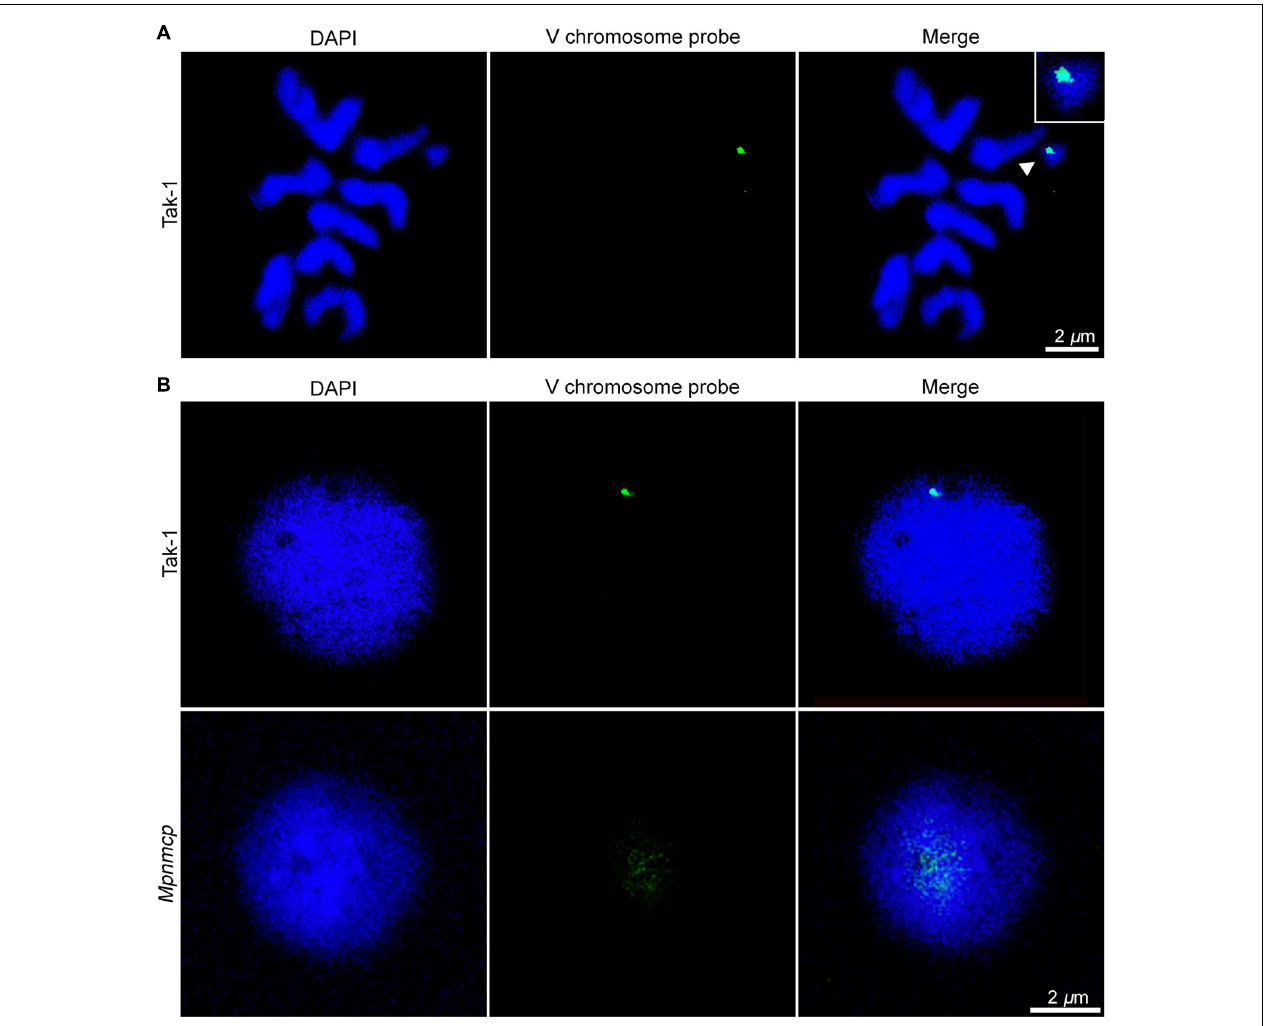
FIGURE 5 | Fluorescence in situ hybridization (FISH) analysis of repeats from the V chromosome. (A) Chromosome spread confirms the specificity of FISH probes to the V chromosome (pointed by an arrowhead). The scale bar represents 2 µ m. (B) Distribution of the probed genomic region from V chromosome in Tak-1 (top row) and Mpnmcp mutant (bottom row) nuclei. The nuclei were isolated from vegetative thalli fixed with 0.1% formaldehyde. The scale bar represents 2 µ m. Nuclei are counterstained with 4 (cid:48) ,6-diamidino-2-phenylindole (DAPI)